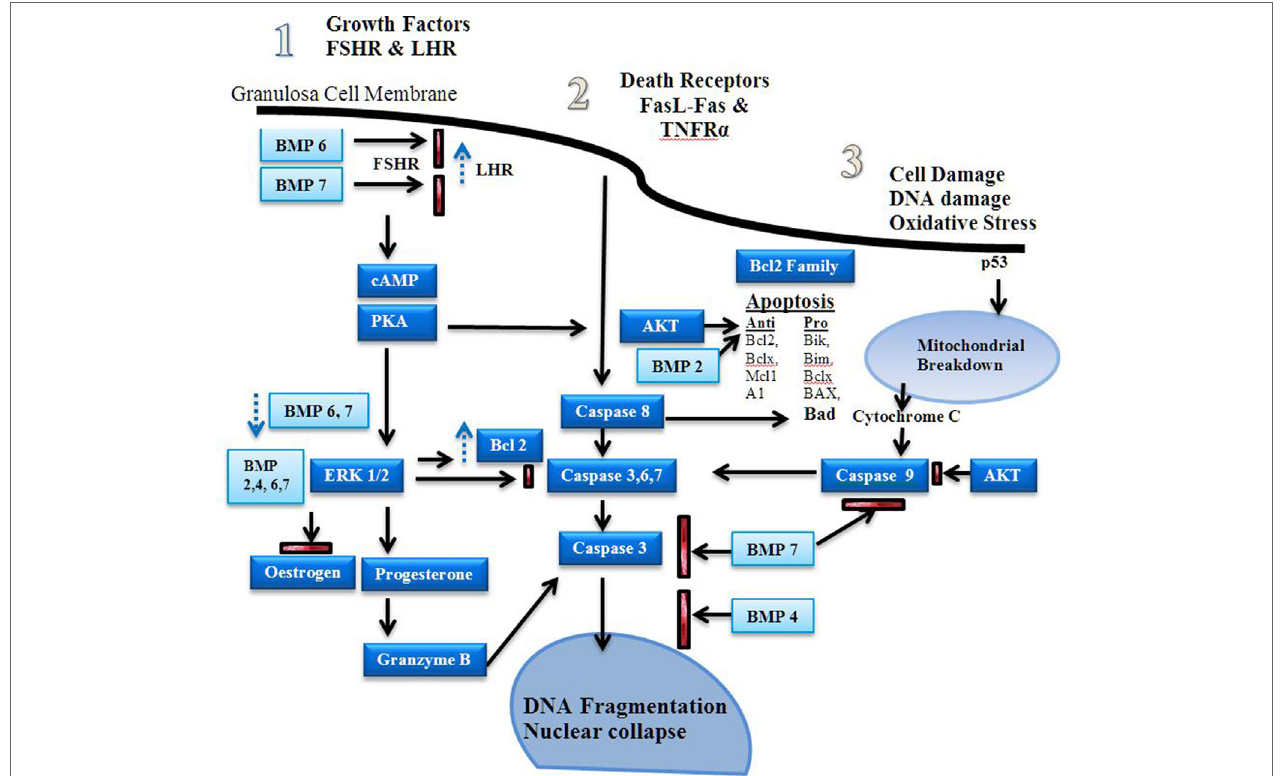
FiGURe 3 | Apoptosis signaling pathways. Estrogen is a major driver of follicular growth and its effects results in inhibition of apoptosis. There are three main areas of apoptosis inducement: 1. growth factors, 2. death receptors, and 3. cell damage (20). Before antral cavity formation ovarian follicle androgens increase the receptor of follicle stimulating hormone (FSH) expression and high levels of BMPR1B activity, possibly via BMP6 and 7, suppress LHR expression (21). Antiapoptotic FSH induced cAMP–PKA promote ERK1/2 signaling, which increases Bcl-2 and promotes estrogen production in favor of progesterone synthesis (22–24). The bone morphogenetic proteins (BMPs) 2, 4, 6, and 7 inhibit progesterone synthesis, which reduces caspase 3, 6, and 7 production during the follicular phase (25). Dysregulation of the BMPs induces granzyme B synthesis leading to increased DNA fragmentation (16). Fas ligand (FasL) and TNFR activity induces caspase 8 induced DNA fragmentation (26). BMP 7 inhibits caspase 3 activity. Estrogen via the estrogen receptor has also been shown to reduce FasL activity (27, 28). Stress induced apoptosis via p53 causes mitochondrial breakdown via caspase 9 (29). Mitochondrial apoptosis is dependent on the ratio of pro